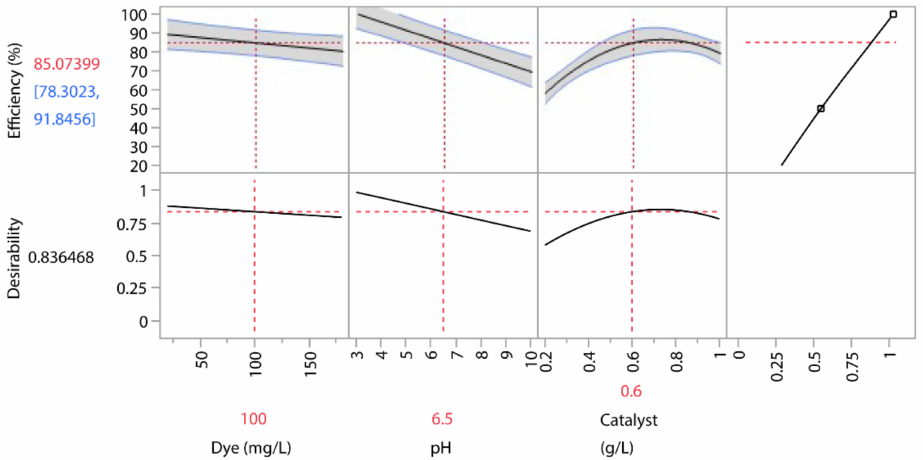
Figure 7. Photocatalytic process optimisation